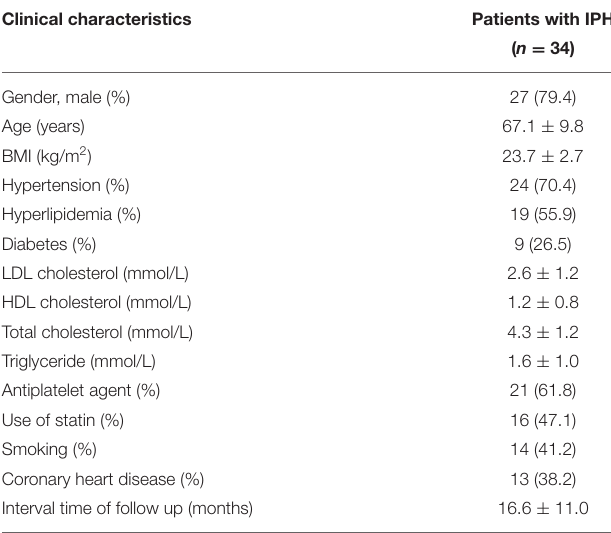
TABLE 1 | Subject characteristics at